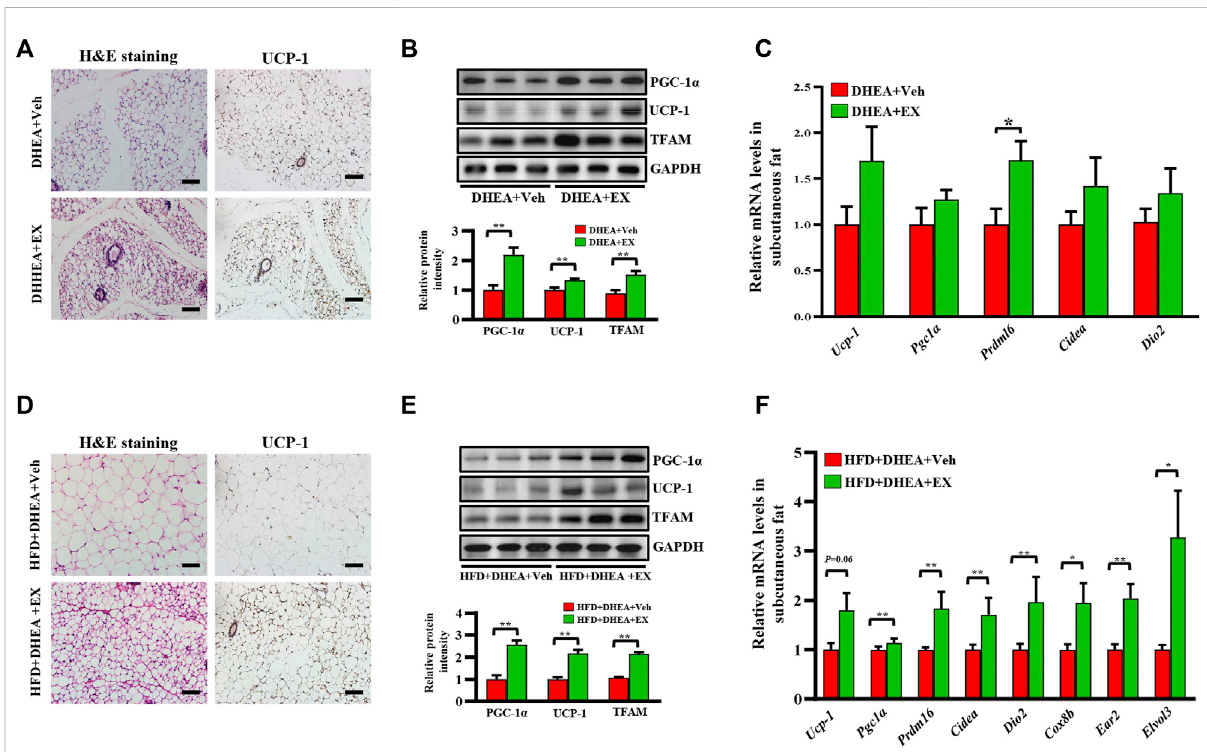
FIGURE 5 Enoxacin treatment promote the browning of white adipose tissue in PCOS. (A) H&E staining and UCP-1 immunohistochemical staining of subcutaneous adipose tissue under chow diet conditions. Scale bar: 100 μ m; (B) Western analysis of PGC-1 α , UCP-1 and TFAM in subcutaneous adipose tissue upon chow diet. Relative intensity was calculated by using ImageJ software. (C) mRNA expression of thermogenic genes of subcutaneous adipose tissue upon chow diet; (D) H&E staining and UCP-1 immunohistochemical staining of subcutaneous adipose tissue under HFD. Scale bar: 100 μ m; (E) Western analysis of PGC-1 α , UCP-1 and TFAM in subcutaneous adipose tissue under HFD. Relative intensity was calculatedbyusingImageJsoftware; (F) mRNAexpressionofthermogenicgenesofsubcutaneousadiposetissueunderHFD.Valuesarerepresented as the mean ± SE. n = 5 – 6. P values were determined by two-tailed Student ’ s t -test. * p < 0.05, ** p < 0.01. DHEA, dehydroepiandrosterone; Veh, vehicle; EX,